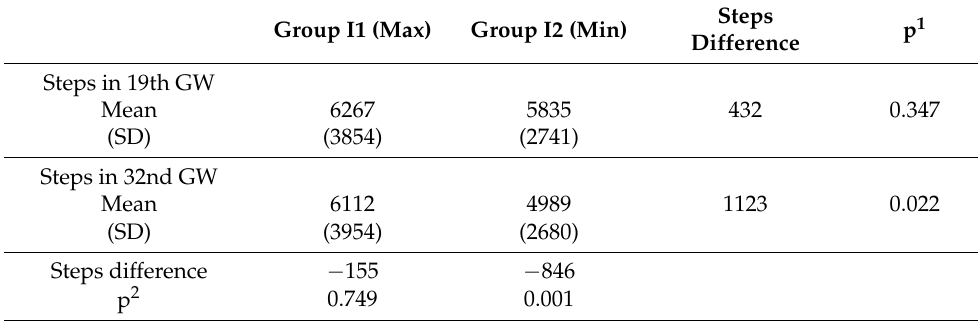
Table 2. Change in mean steps/day after